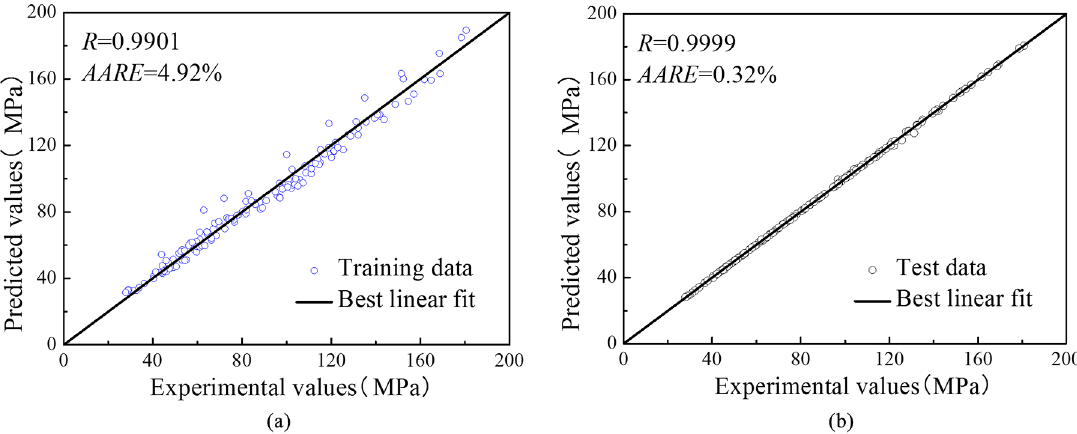
Figure 8. Correlation between experimental flow stress data and predicted flow stress data by (a) improved Arrhenius-type constitutive model and (b) BP-ANN